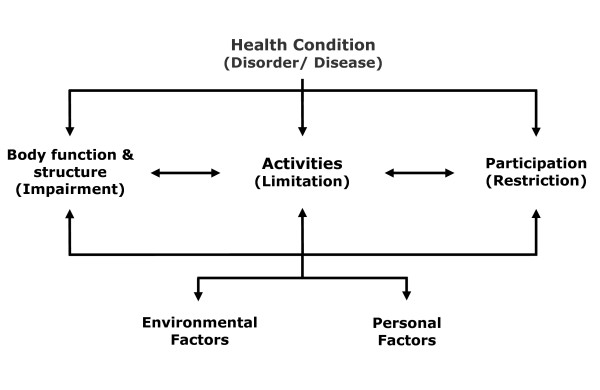
Interaction of ICF-Concepts [2].